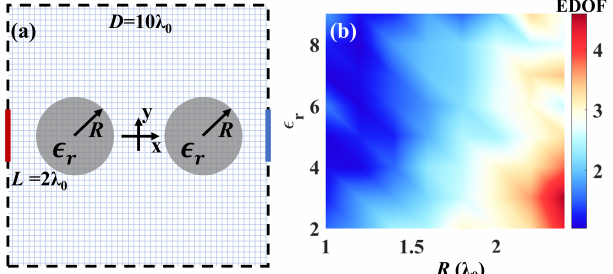
Figure 5. EDOF limit in an inhomogeneous environment with double cylindrical scatterers: ( a ) Di- agram of the double-scatterer environment. The lengths of the source and receiving lines are both L = 2 λ 0 , and the distance between them is D = 10 λ 0 . Two identical dielectric cylinders, with the radius R and relative permittivity (cid:101) r , are placed in the left and right quadrisection points between the source and receiving lines; ( b ) EDOF limit versus R and (cid:101) r .